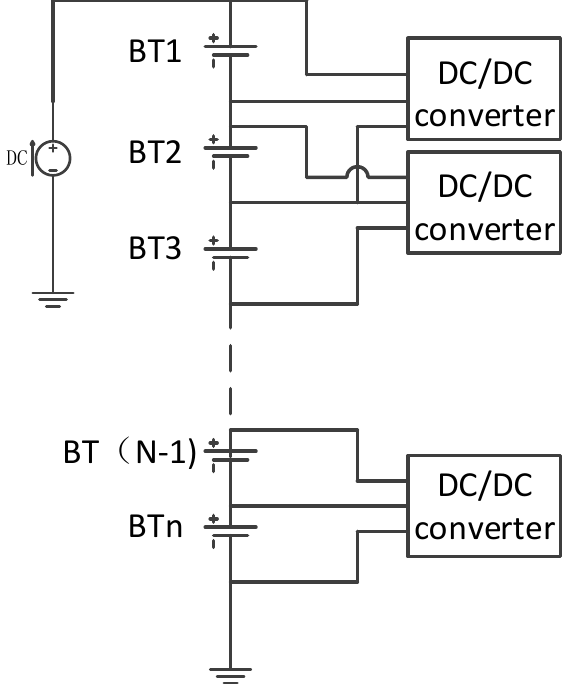
Figure 8. Principle of distributed DC–DC active balance.